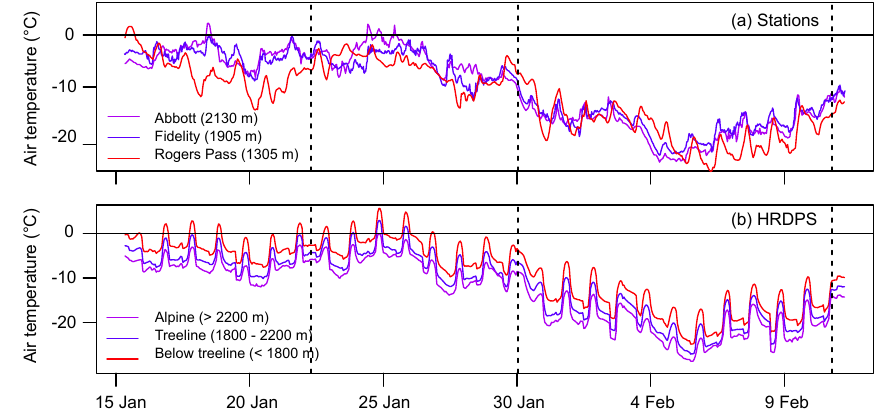
Figure 3. Air temperatures (a) measured at stations and (b) forecast by the High-Resolution Deterministic Prediction System (HRDPS) in Glacier National Park. Forecasts were grouped by grid point elevation, with 35 alpine points ( > 2200m), 92 treeline points (1800 to 2200m), and 98 below treeline grid points ( < 1800m). The median temperature in each band is shown. Surface hoar crystals were buried on 22, 29 January, and 10 February as indicated by the vertical dashed